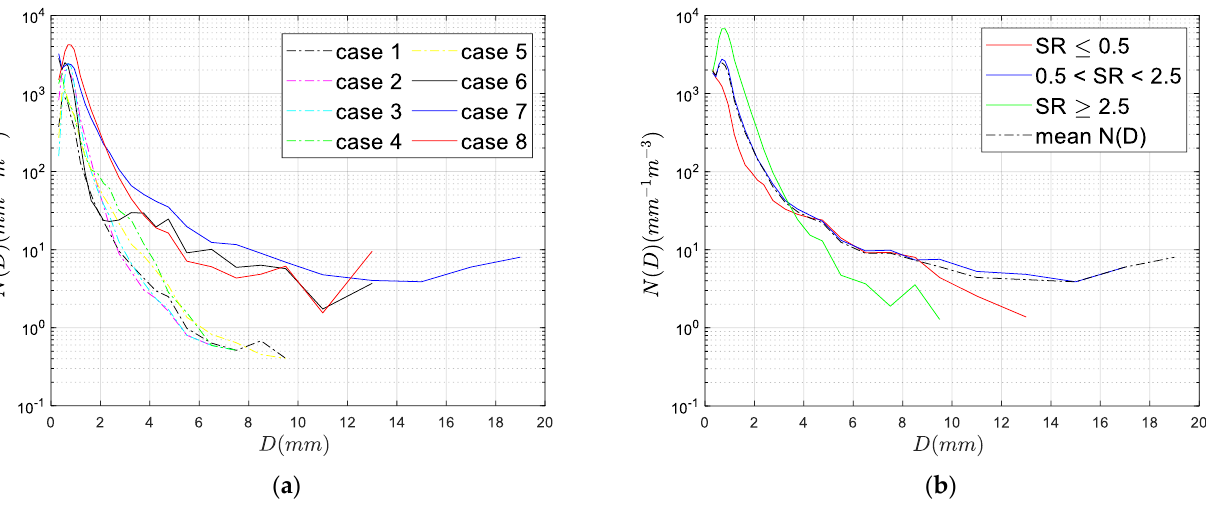
Figure 2. ( a ) PSDs of eight snowfall events, ( b ) Mean PSDs corresponding to three types of snow